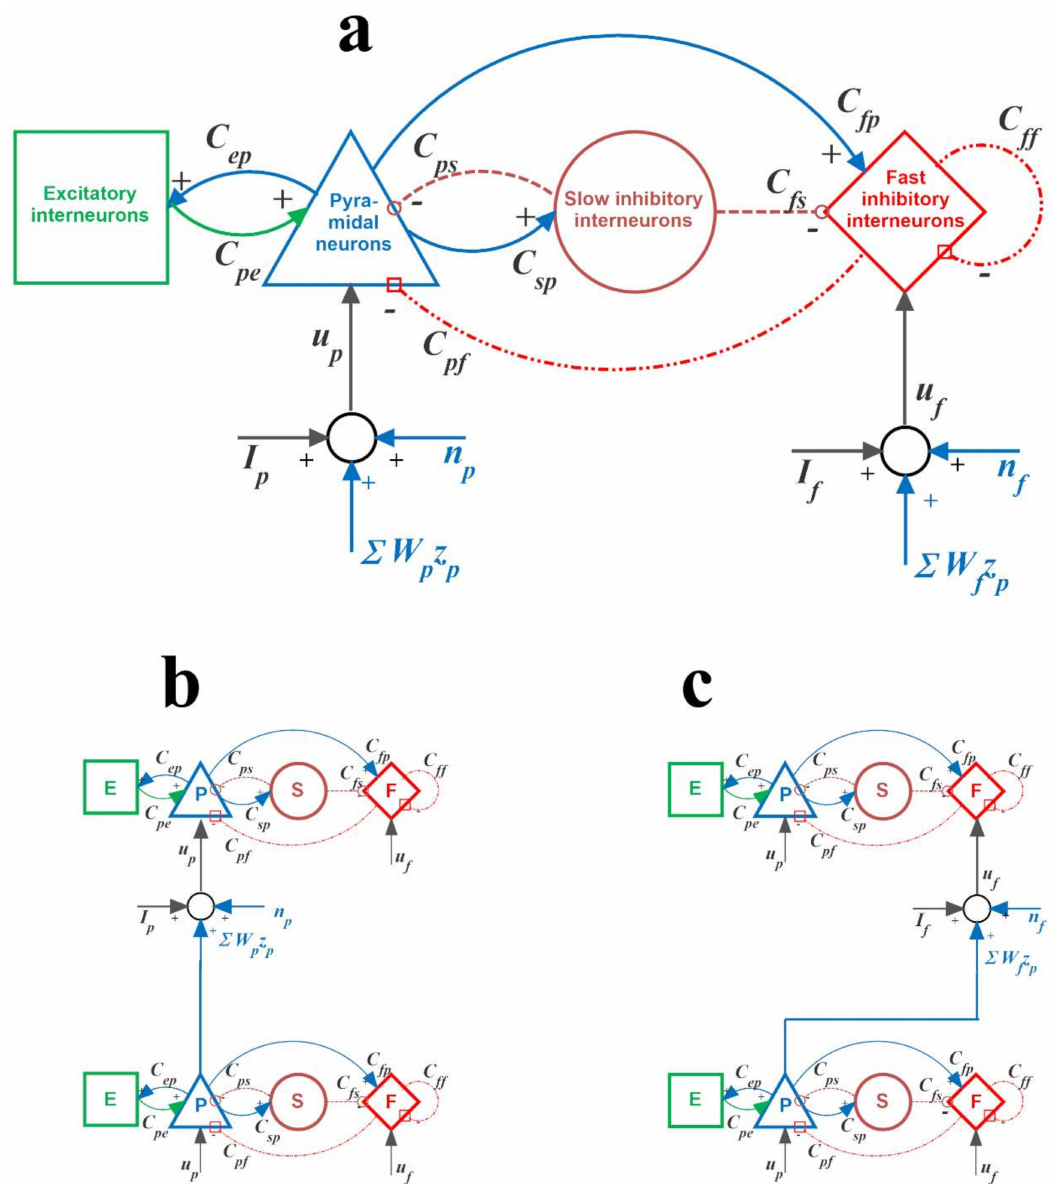
Figure 1. ( a ) Scheme of the neural mass model simulating the dynamics in a single Region of Interest (ROI). Blue continuous lines with arrows indicate glutamatergic excitatory synapses; red dash-dotted lines with open squares indicate GABAergic faster inhibitory synapses; brown dotted lines with open circles indicate GABAergic slower inhibitory synapses. Symbol C ij denotes the synaptic contacts among the neural populations where the first subscript and the second subscript represent the postsynaptic population and presynaptic population, respectively. u p and u f represent inputs to the pyramidal neuron population and to the fast inhibitory interneuron population, respectively. These inputs can come from the external environment ( I p and I f , respectively), from noise ( n p and n f , respectively) or from glutamatergic synapses from pyramidal neurons in other ROIs. ( b ) an example of excitatory connections between two ROIs via a direct link from the pyramidal neurons of the source ROI to the pyramidal neurons of the target ROI. ( c ) an example of a bisynaptic inhibitory connection, from the pyramidal neurons of the source ROI to the fast inhibitory neurons of the target ROI (which, in turn, inhibit pyramidal neurons in the target